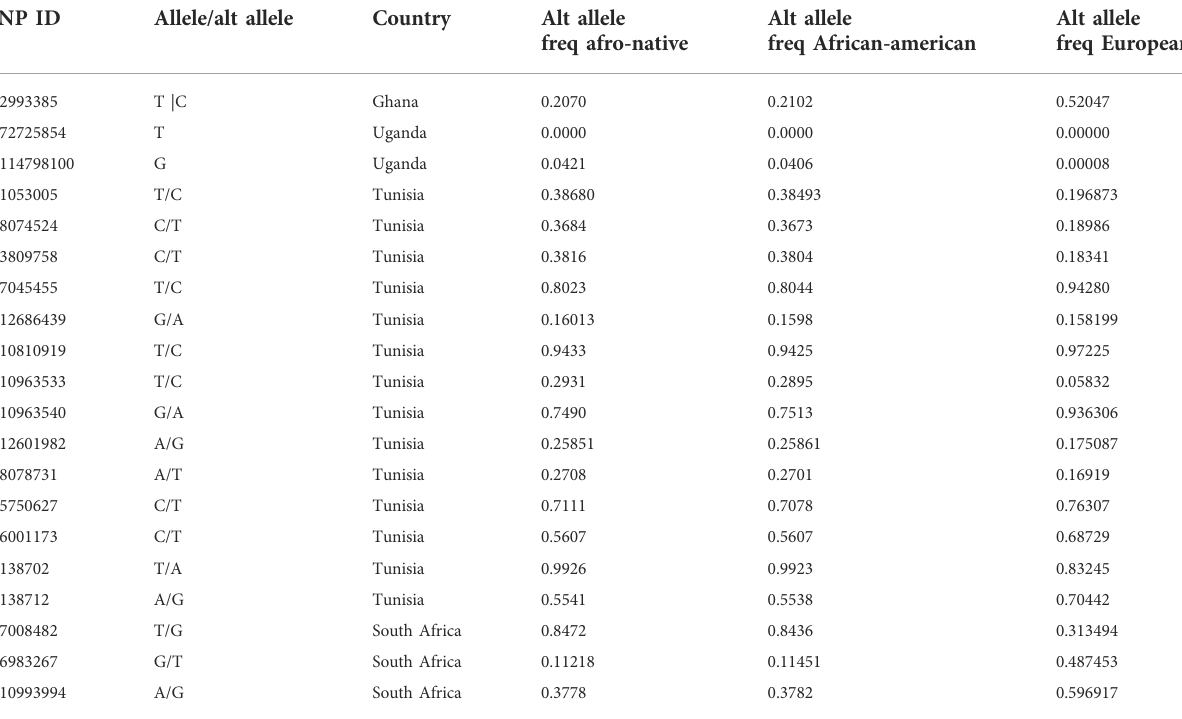
TABLE3Comparisonofallelefrequenciesinvariouspopulationsofthemostsigni fi cant( p < 0.05)SNPsassociatedwithprostatecancerinAfro-native